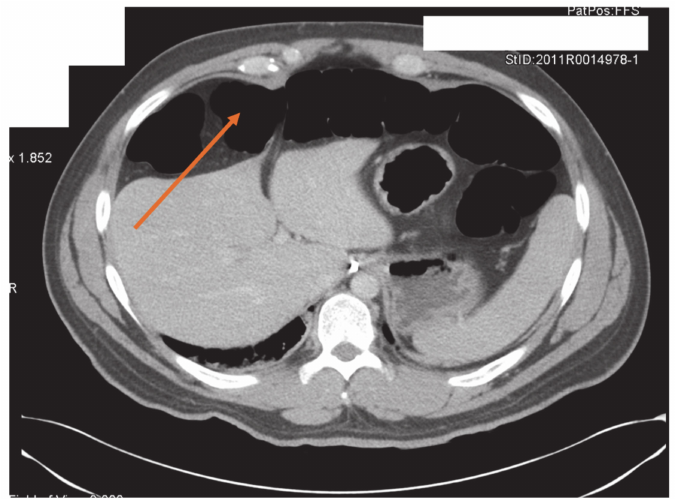
Figure 2. Axial computed tomography scan shows gas-filled large bowel between the liver and anterior abdominal wall (orange